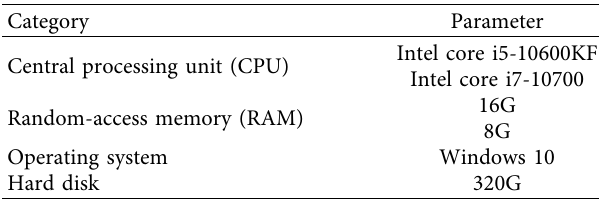
Figure 8: The process of the intelligent teaching assistant function. Table 1: The main test environment of the